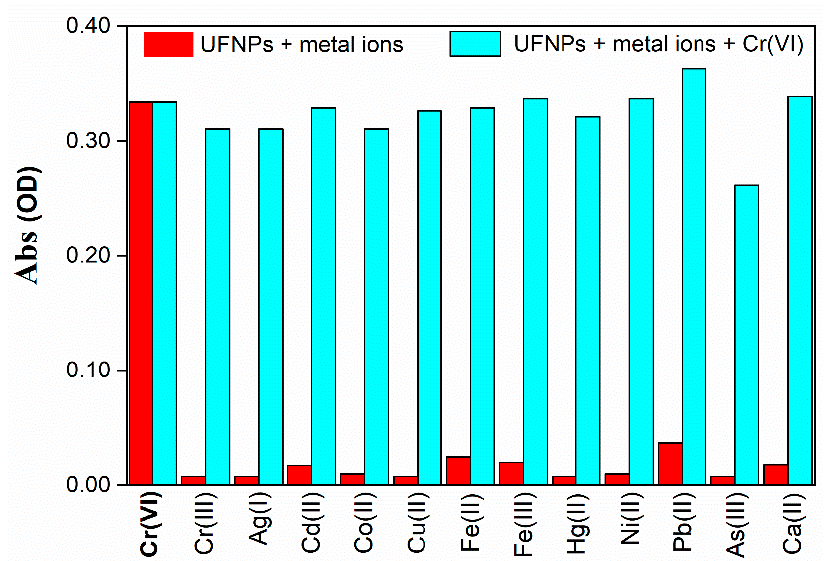
Figure 7. Absorbance of N-CDs-W-THF solution at 550 nm upon the addition of different HM ions in the absence (red bars) and in the presence (cyan bars) of Cr(VI) at a concentration of 100 µM. Calcium ions at a concentration of 1000 µM were also added for comparison. Note that As(III) is present as the anion AsO 33 − in water, which is in contrast to all the other metals, which are present as cations.